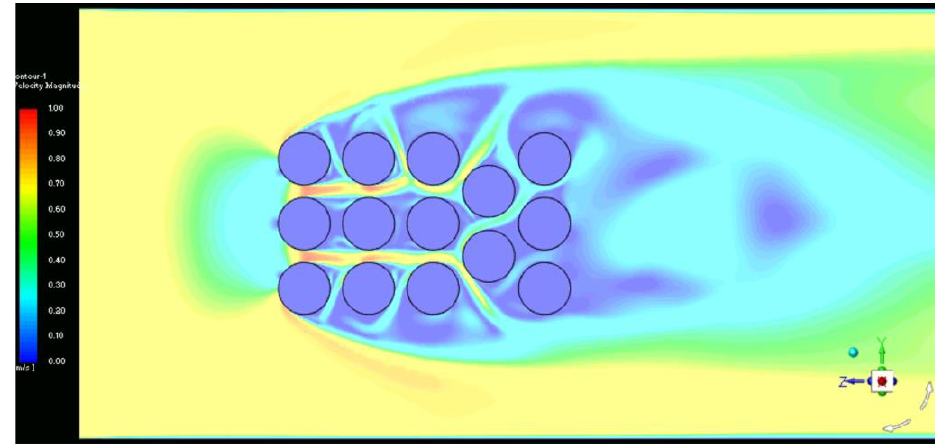
Figure 15. Velocity contours in the middle longitudinal